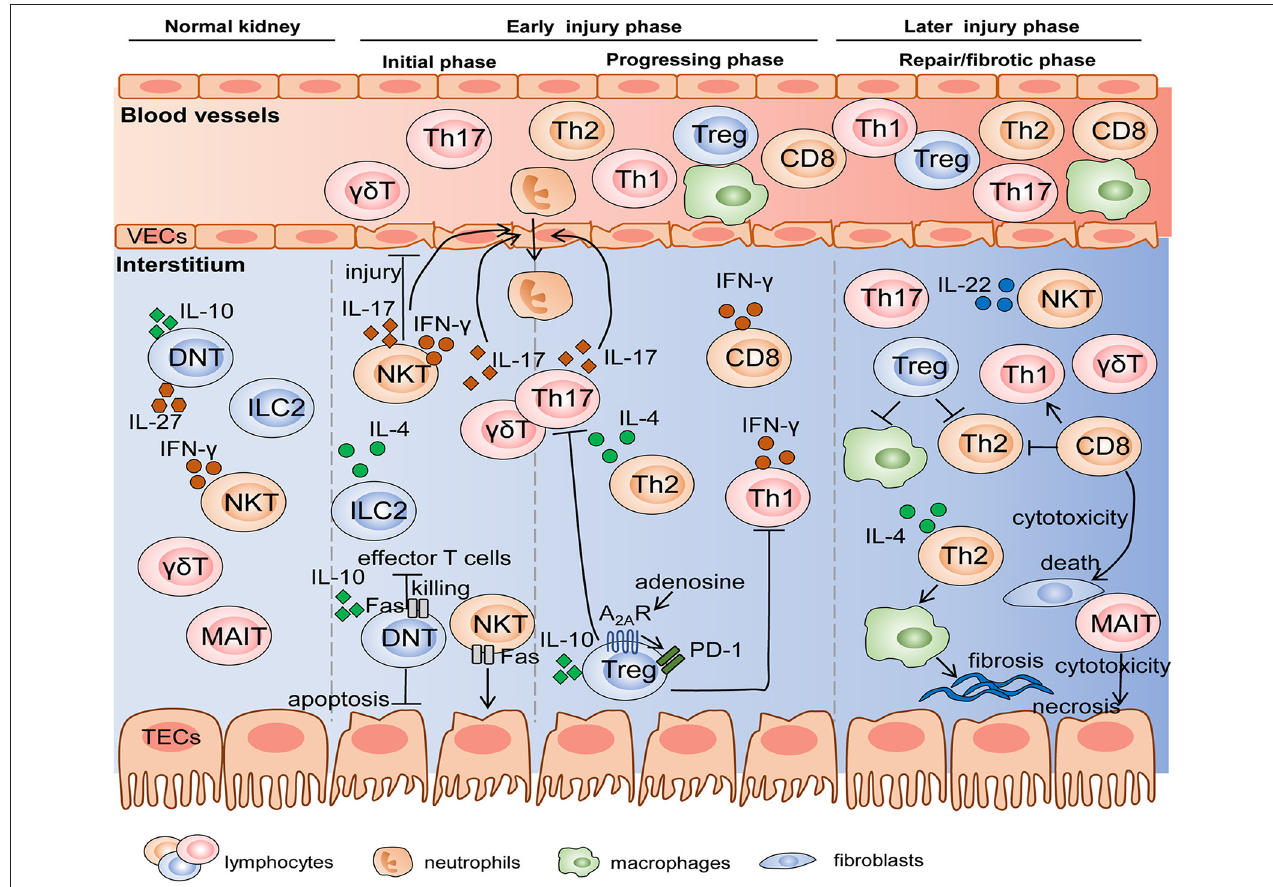
FIGURE 2 | The mechanisms of diverse lymphocyte subsets on AKI and renal fibrosis in the different stages. Innate and innate-like lymphocytes reside in normal kidneys and become early responders to renal injury. Subsequently, differentiated adaptive T cells migrate into the kidney in progressing phase, and some of these cells like Treg and MAIT participate in the repair or fibrotic process. Cell-cell interactions are achieved by the production of various cytokines and cytotoxicity mediated by FasL/Fas. VEC, vascular endothelial cell; TEC, tubular epithelial